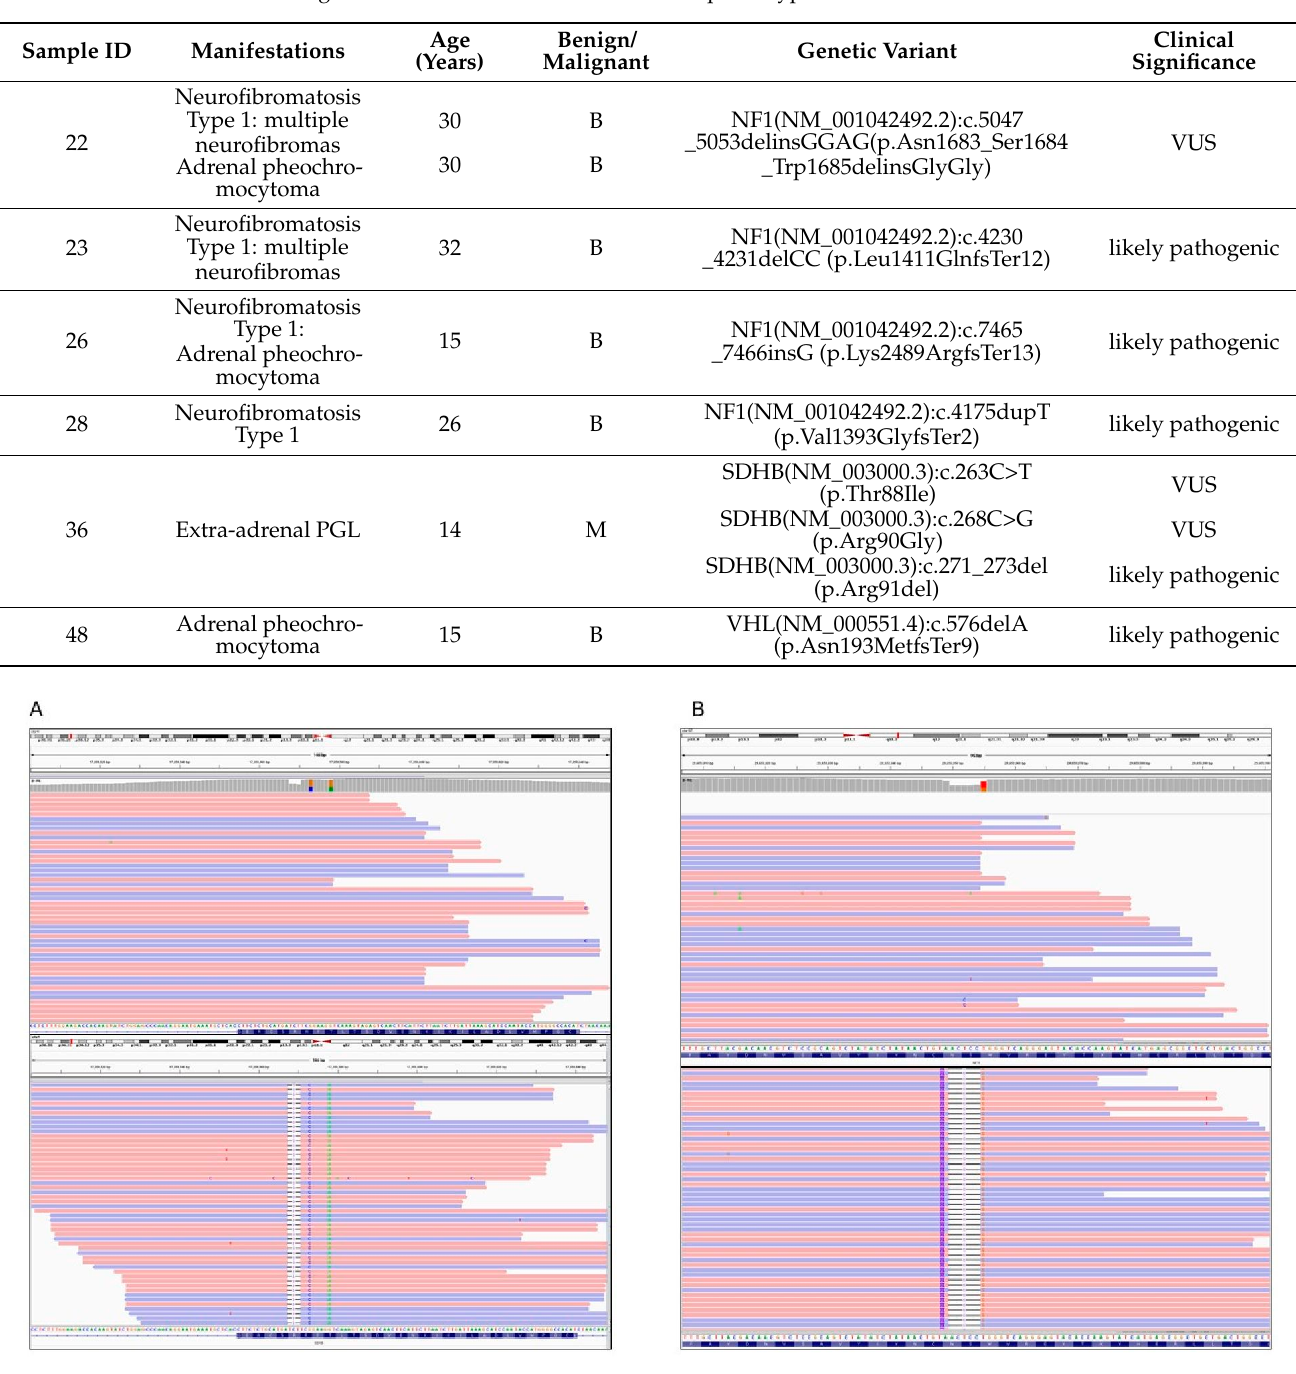
Table 4. Novel genetic variants and associated clinical phenotypes identified in our recent cohort.